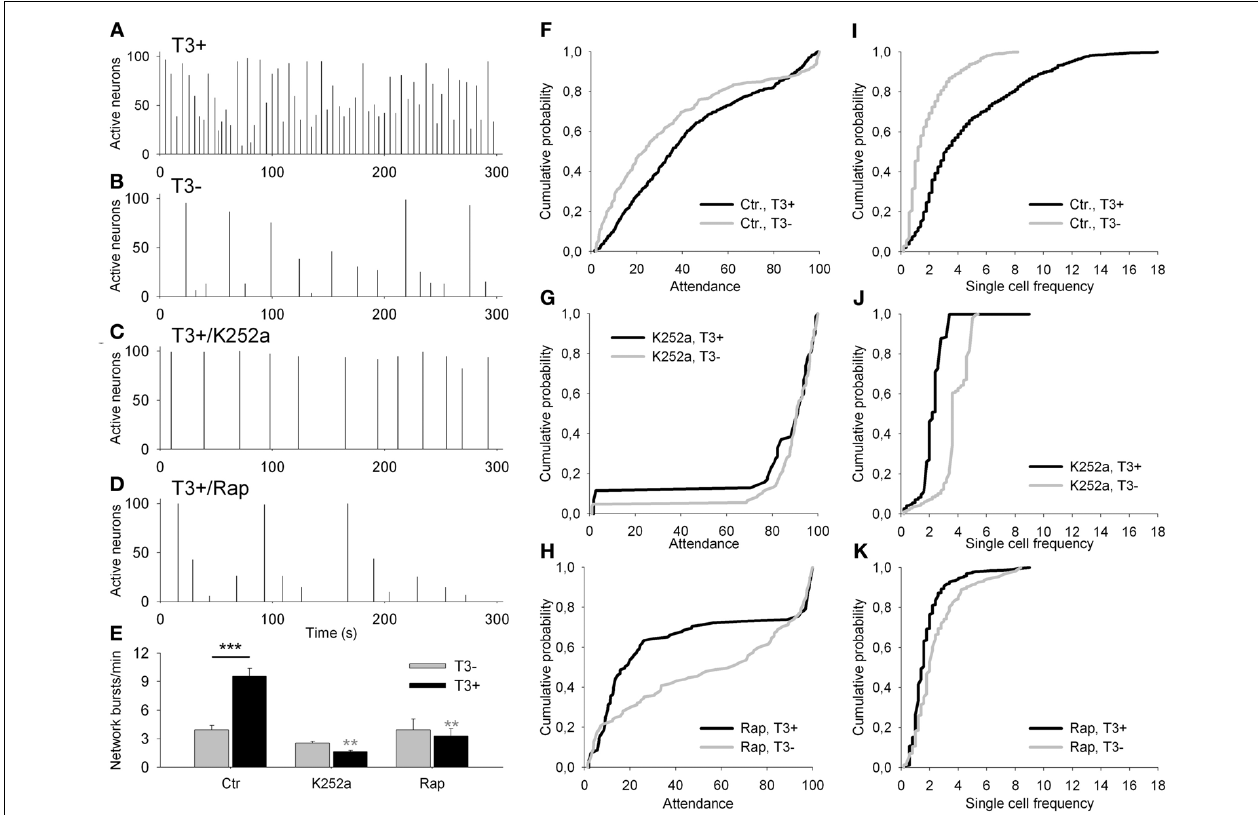
FIGURE 8 | (A–D) Network activity histograms of representative fields recorded at 13–14DIV with Fluo-4 calcium imaging. Bars show the percentage of active neurons against time. (E) The graph shows the network burst frequency for T3 − (gray bars) and T3 + (black bars) in control sets of cultures (Ctr), and in cultures